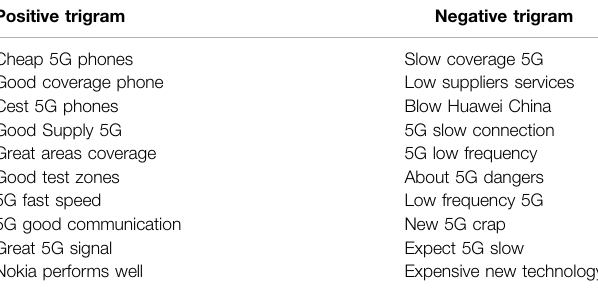
TABLE 6 | Most frequent positive trigrams for next generation mobile network